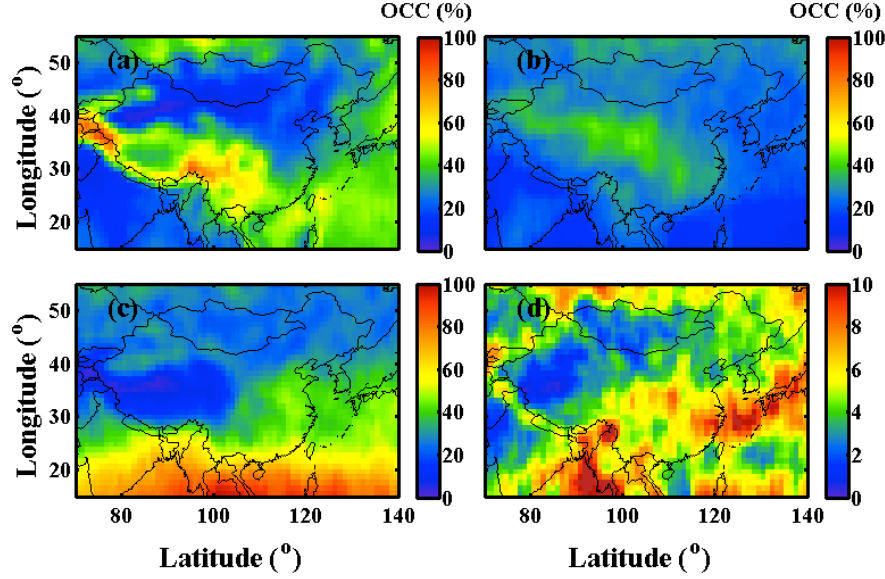
Figure 6. Distributions of cloud occurrence for ( a ) low-level, ( b ) mid-level, ( c ) high-level, and ( d ) deep clouds. Please note the color bar magnitude in ( d ) is smaller than that for the other three.